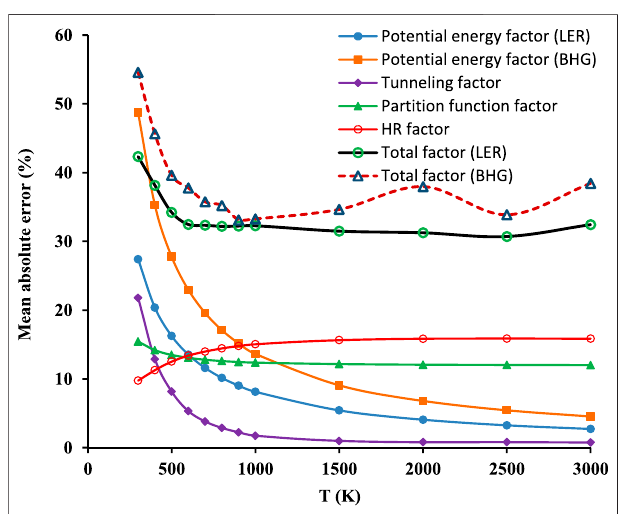
FIGURE 11 | Temperature dependence of systematic errors of the RC-TST factors, namely total factors f(T) and its constituents: potentialenergy f V ( T ), partition function f Q ( T ), and hindered rotation f HR ( T